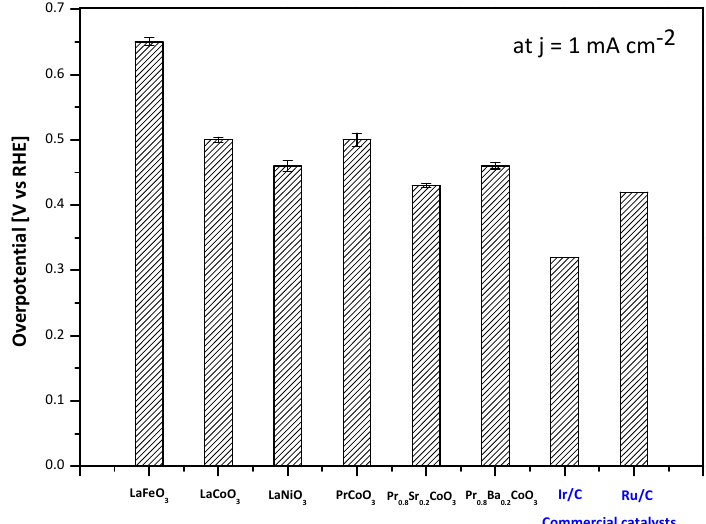
Figure 5. Comparison of oxygen evolution reaction (OER) overpotential values (V vs. reversible hydrogen electrode RHE at 1 mA cm − 2 of the prepared perovskites.